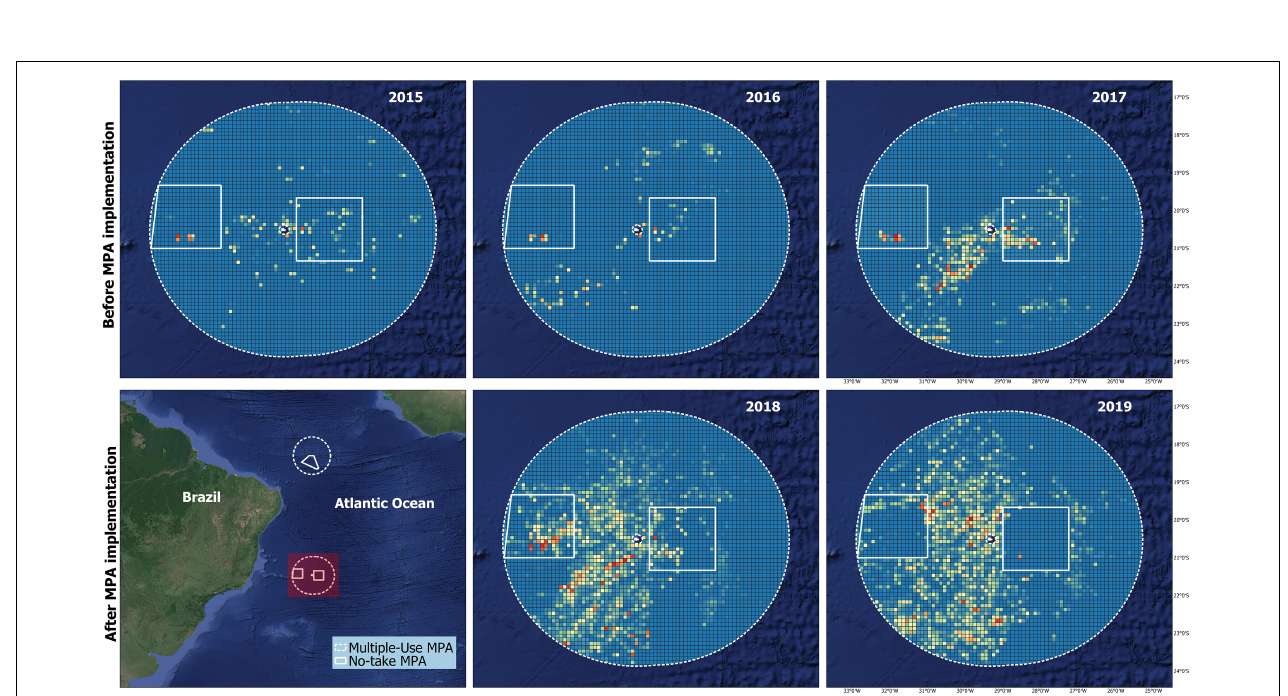
FIGURE 2 | Occurrence of fishing activity (“likely fishing days”) within the no-take and the multiple-use large-scale MPAs surrounding the Trindade Island and the Martin Vaz Archipelago (TMV) over 5 years: 2015–2017 ( top row ), when the MPAs had not been declared; and 2018–2019 ( bottom row ), when the MPAs have been